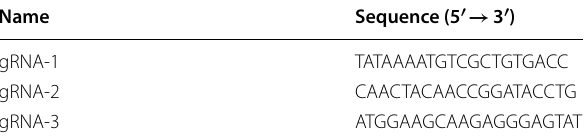
(Additional file 1: Figure S1) was codon optimized for expression in K. marxianus . The homologous recombi- nation strain was generated by transforming the recipi-